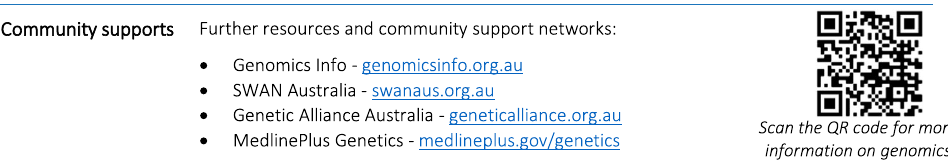
Fig. 1 Example pre- fi lled “ family report ” (autosomal recessive template). This “ family report ” includes sections stating the genomic test type and result; inheritance and recurrence information with pictorial representation; follow up plans and information